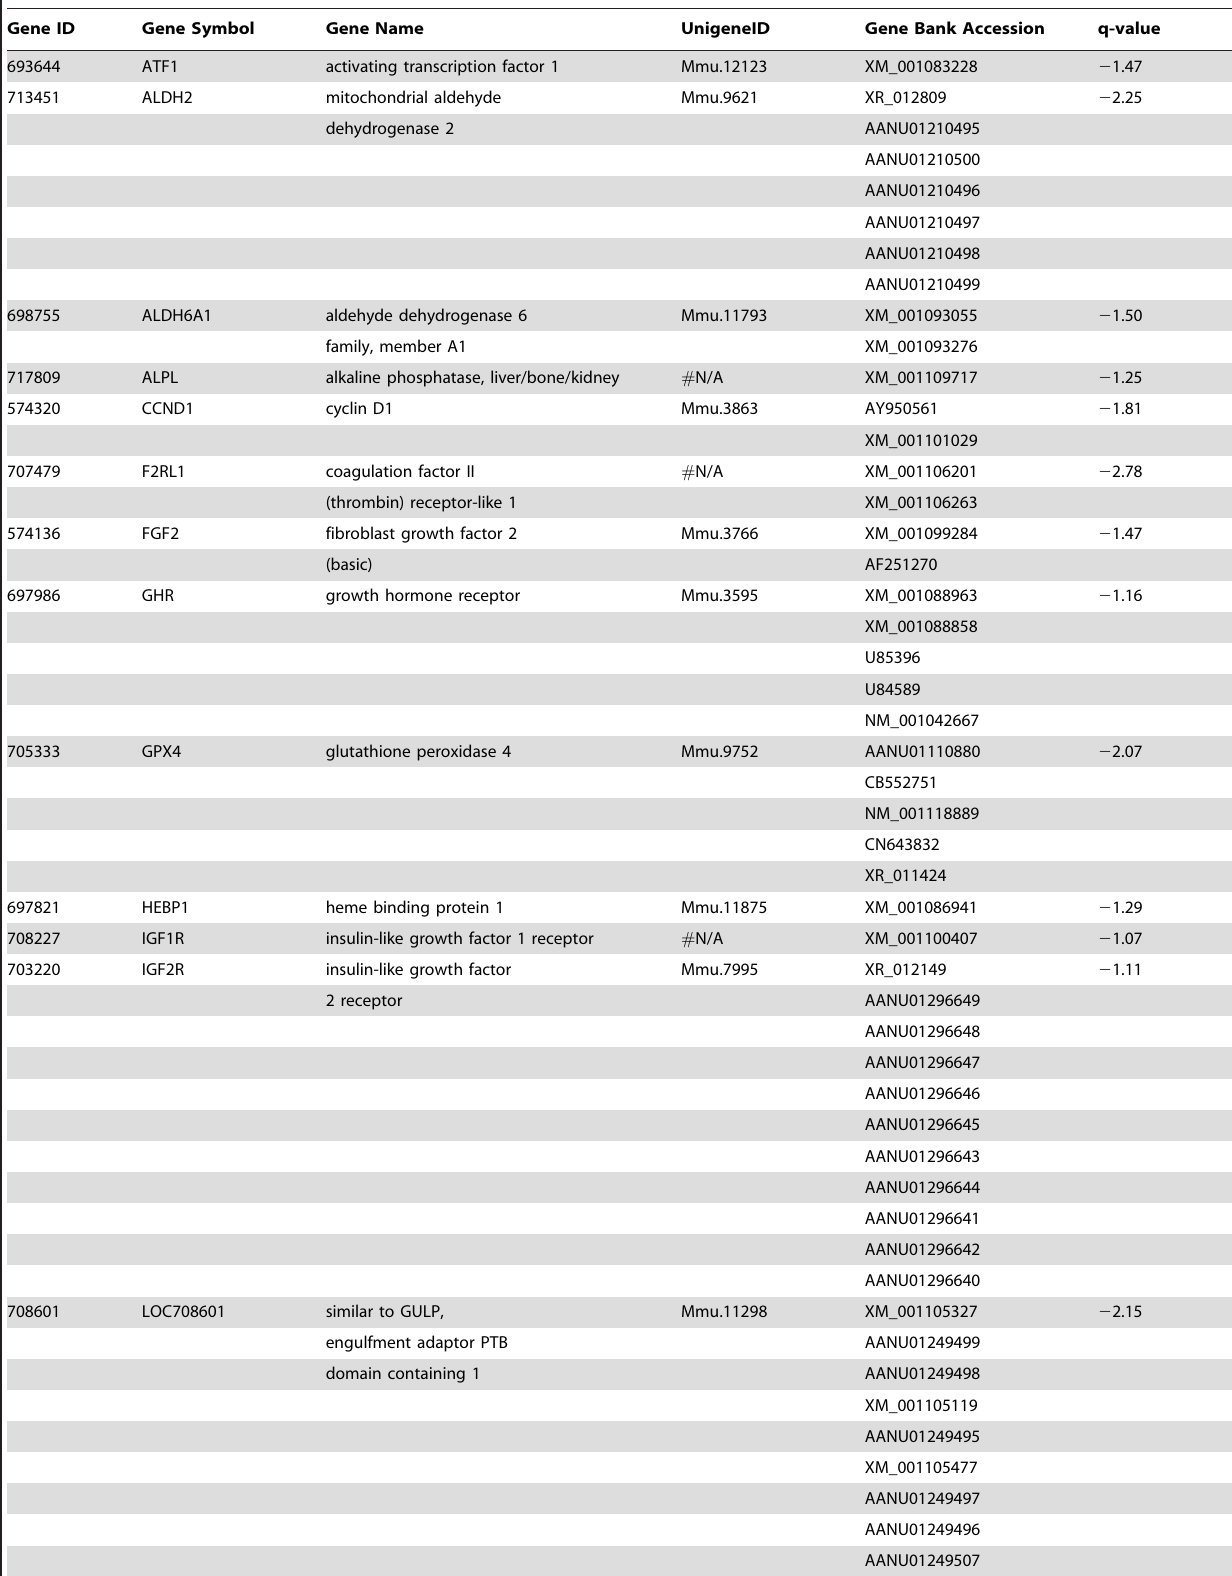
Table 4. Differentially expressed transcripts that display altered expression patterns following in vitro embryo